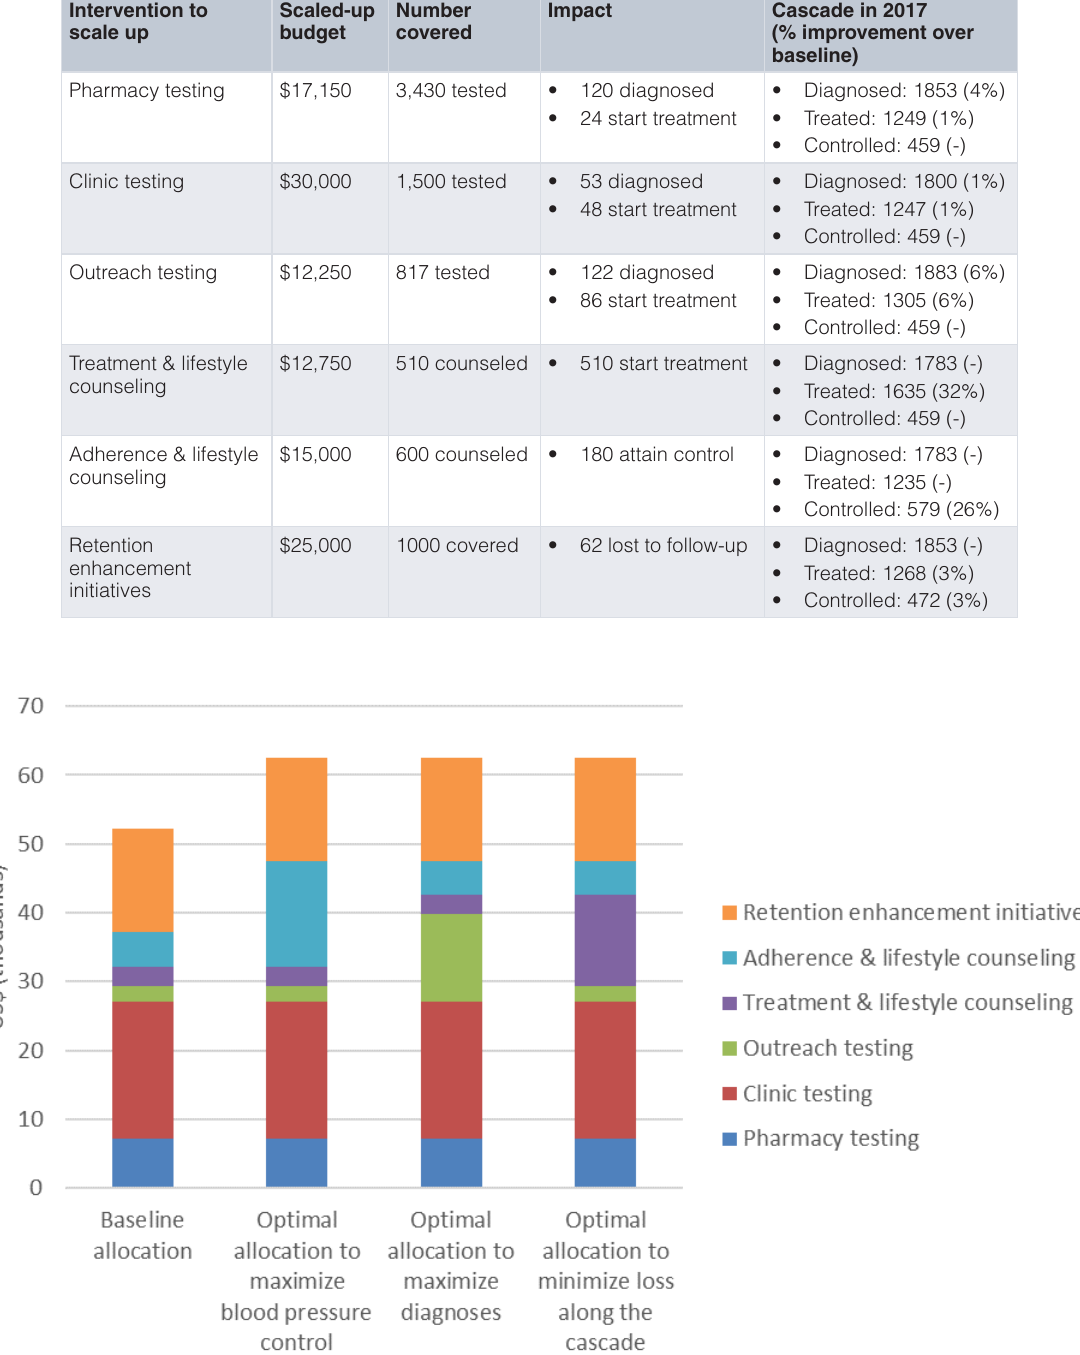
Table 2. Illustrative scenarios showing different intervention scale-up options, based on the treatment cascade introduced in Figure 3. Intervention to scale up